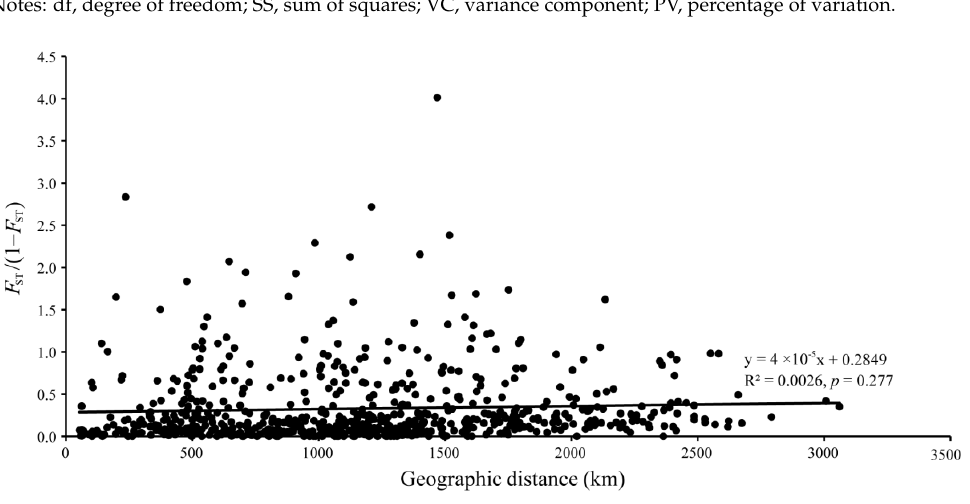
Figure 3. The regression of paired F ST /(1 − F ST ) vs. the geographic distances was not significant for nSSRs data.